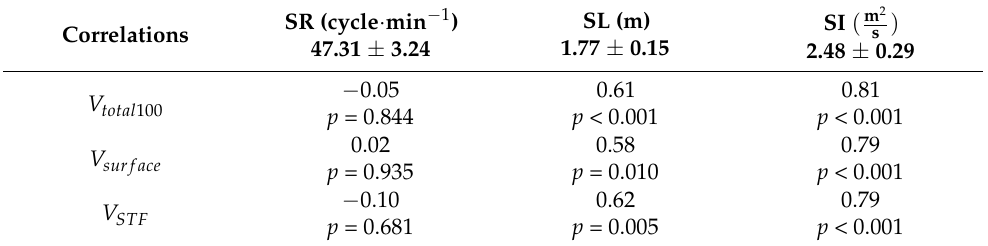
Table 5. Correlations of kinematic indices of SR , SL , and SI with: V total 100 , V surface , V STF